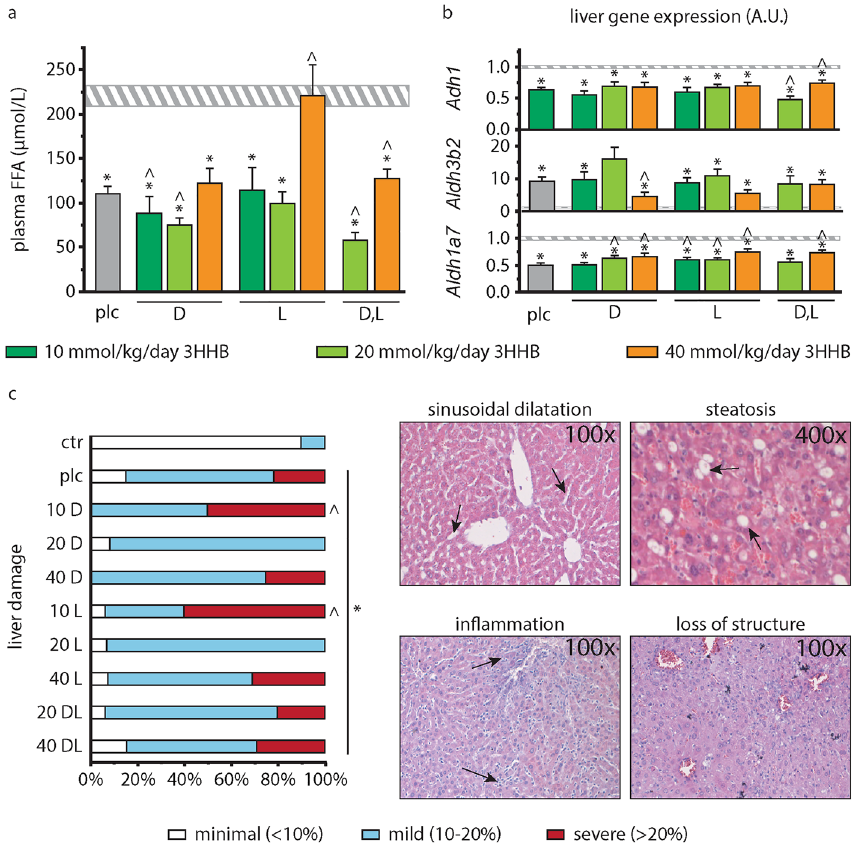
Figure 4. Potential toxicity of increasing bolus doses of pure and mixed racemic enantiomers of 3HHB and impact on markers of the hepatic lipid profile. ( a ) Plasma free fatty acid concentration. ( b ) Relative mRNA expression of liver alcohol metabolism markers Adh1 , Aldh3b2 and Aldh1a7 . Gene expression data are normalized to Rn18s and were expressed as a fold change of the mean of control mice. ( a , b ) Horizontal bar: healthy control (n = 80) grey, vertical bars: placebo (n = 74); d-3HHB: 10 mmol/kg/day (n = 18); 20 mmol/kg/day (n = 19); 40 mmol/kg/day (n = 16); l-3HHB: 10 mmol/kg/day (n = 15); 20 mmol/kg/day (n = 19); 40 mmol/kg/ day (n = 14); d,l-3HHB: 20 mmol/kg/day (n = 16); 40 mmol/kg/day (n = 17). ( c ) Semi-quantitative histological assessment of liver damage. Data are shown as cumulative percentages of the respective group. ctr (n = 79), plc (n = 65), d-3HHB: 10 mmol/kg/day (10D, n = 18); 20 mmol/kg/day (20D, n = 12); 40 mmol/kg/day (40D n = 16); L-3HHB: 10 mmol/kg/day (10L, n = 15); 20 mmol/kg/day (20L, n = 14); 40 mmol/kg/day (40L, n = 13); d,l- 3HHB: 20 mmol/kg/day (20DL, n = 15); 40 mmol/kg/day (40DL, n = 17). ( a–c ) ctr healthy control, plc placebo, 3HHB 3-hydroxybutyl-3-hydroxybutanoate ester. *p ≤ 0.05 vs healthy control; ^ p ≤ 0.05 vs